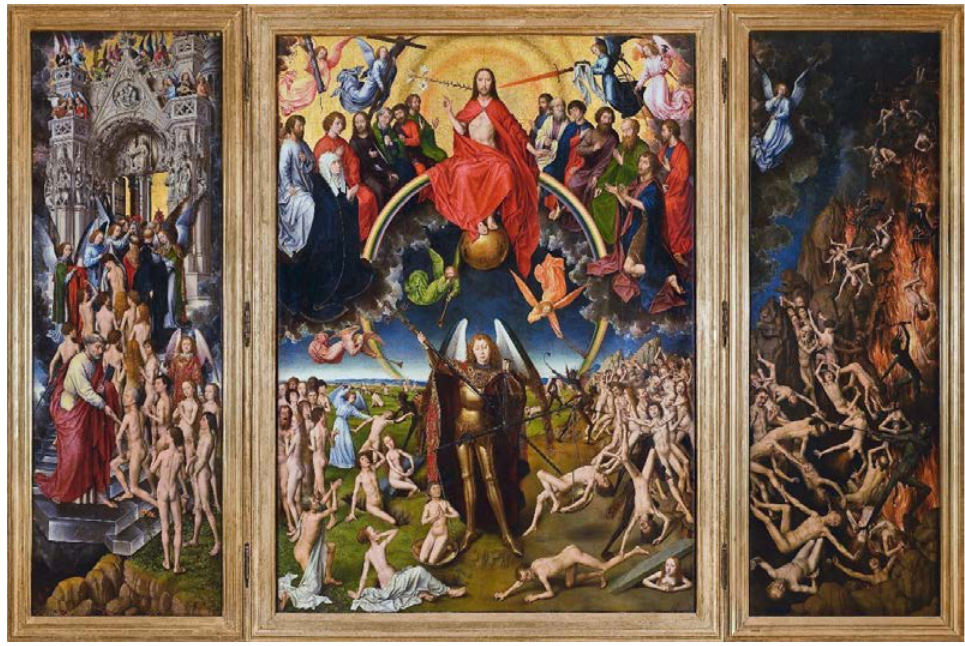
Figure 3. Hans Memling, The Last Judgement (Triptych) , c. 1466–73. National Museum of Gda´nsk (Poland).